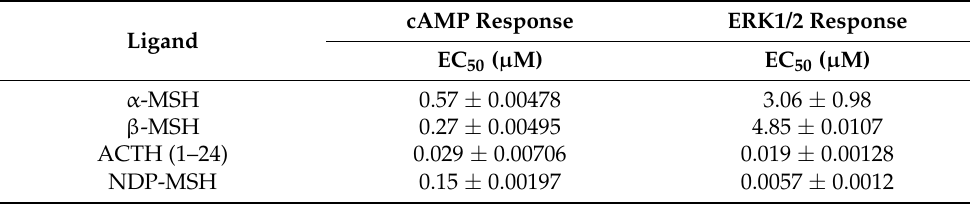
Table 2. The signaling properties of omMc3r in response to ligand